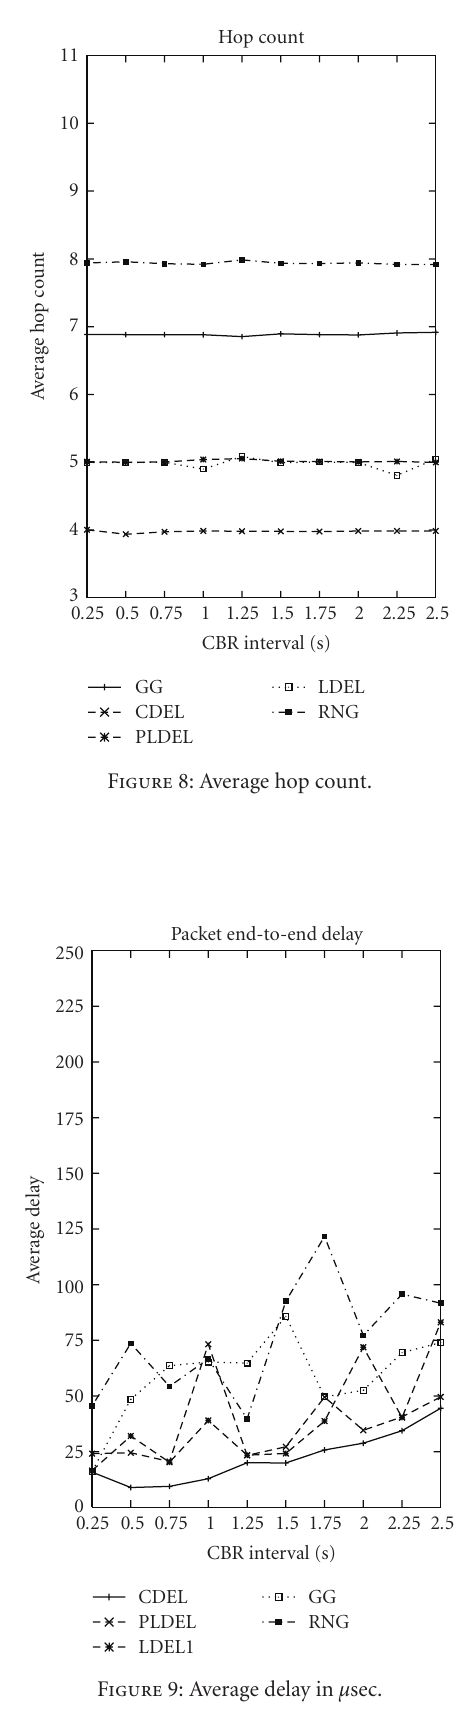
Figure 9: Average delay in μ